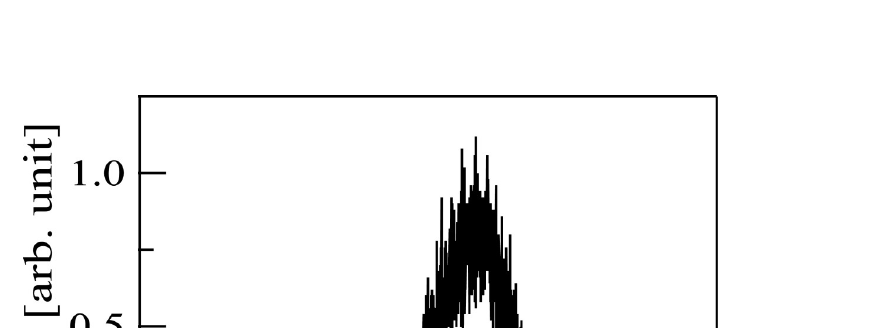
PLOS ONE | https://doi.org/10.1371/journal.pone.0253870 June 25,